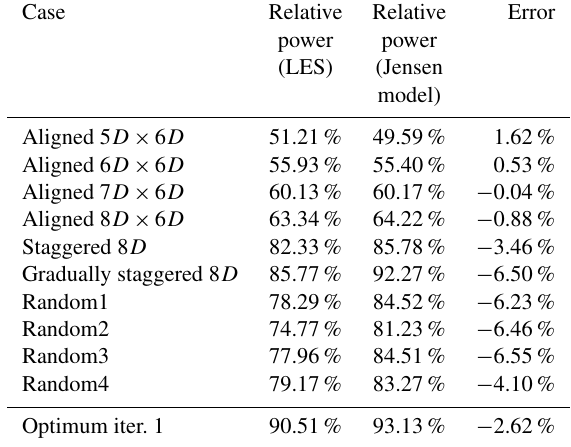
Table 6. Optimum values of k w obtained in different iterations of Algorithm